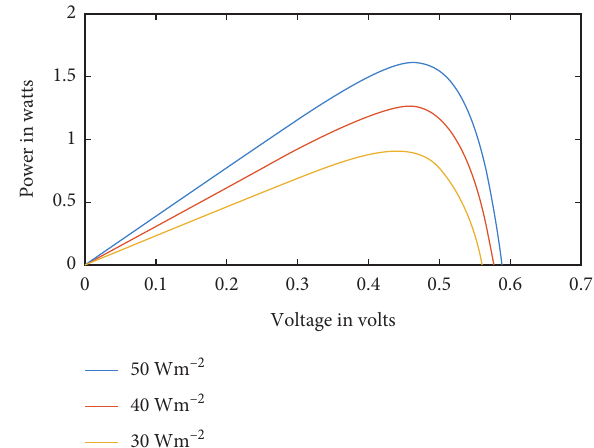
Figure 5: Simulated P-V plot of varying Irradiance of a solar cell.